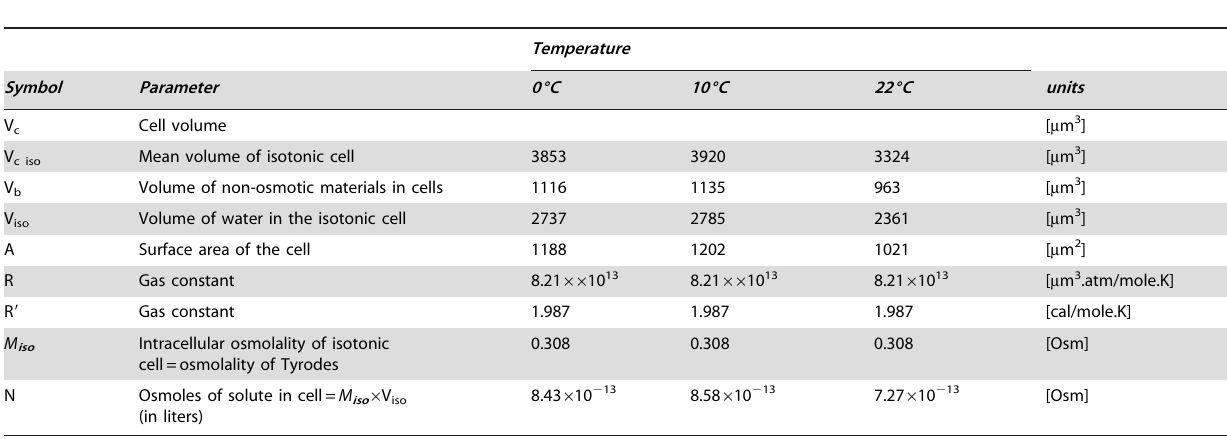
Table 1. Initial values and constants used to calculate L p with Equation